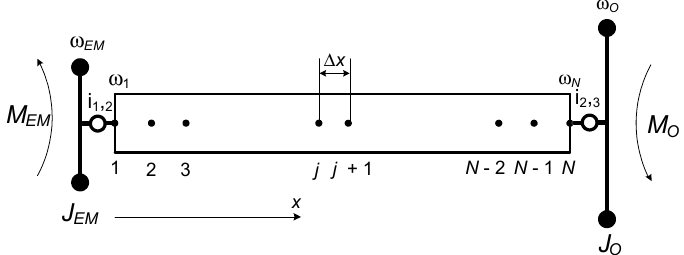
Figure 3. Transfer calculation diagram of an asynchronous long-shaft drive.